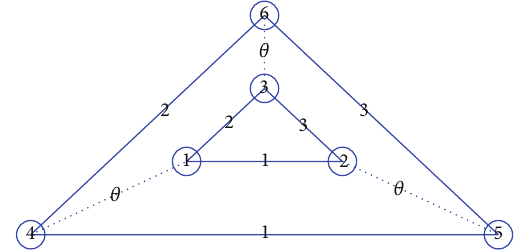
Figure 1: Topology structure corresponding to the coupling matrix (21). The coupling weights of the edges are the values lying on